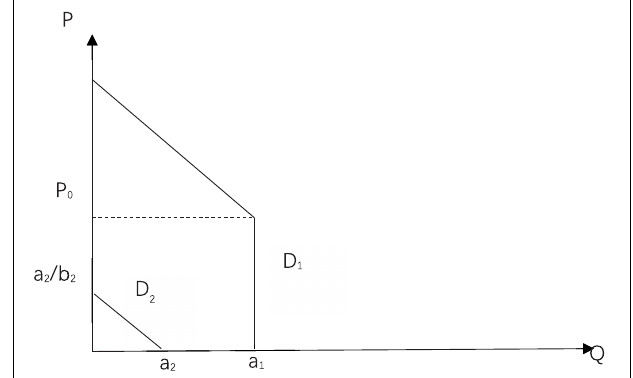
FIGURE 1 | Demand curves for both groups.